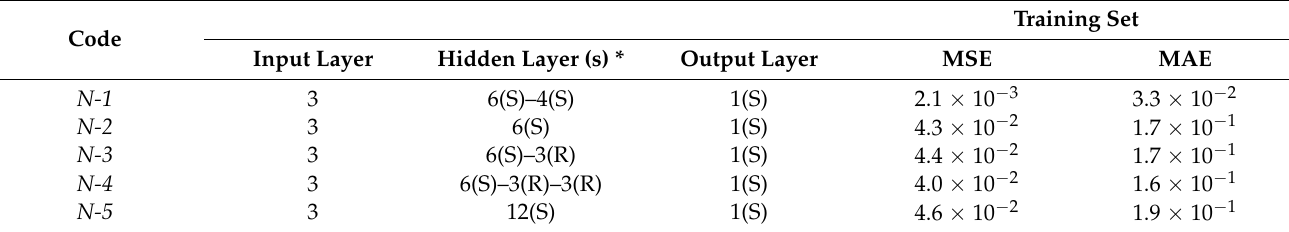
Table 3. Overview of the best ANN